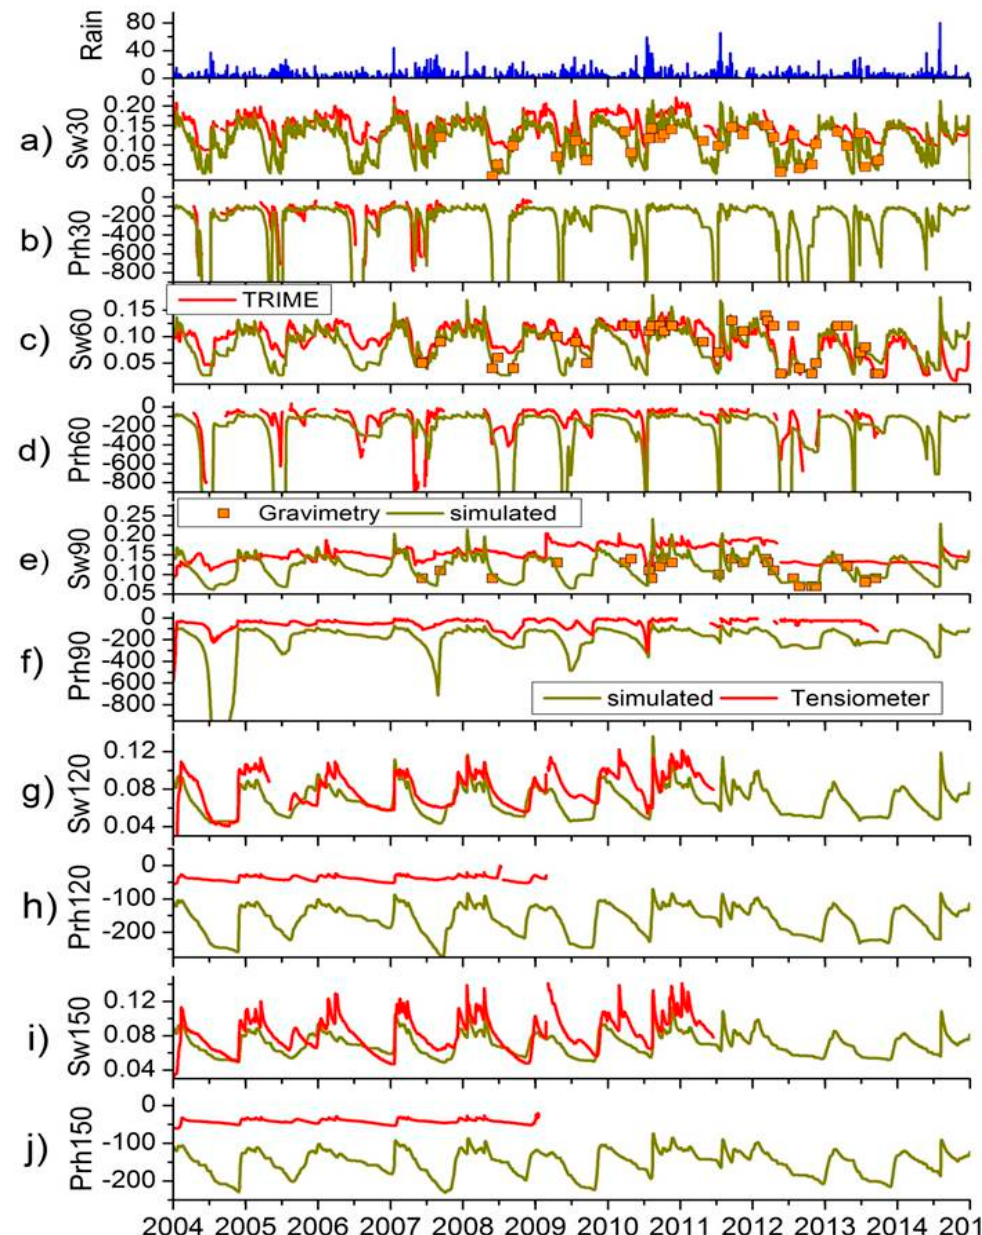
Figure 6. Daily rainfall (Rain) in mm d − 1 , simulated and measured soil water contents (TRIME, Gravimetry) in cm 3 cm − 3 at soil compartments 0–30 cm ( a , Sw30), 30–60 cm ( c , Sw60), 60–90